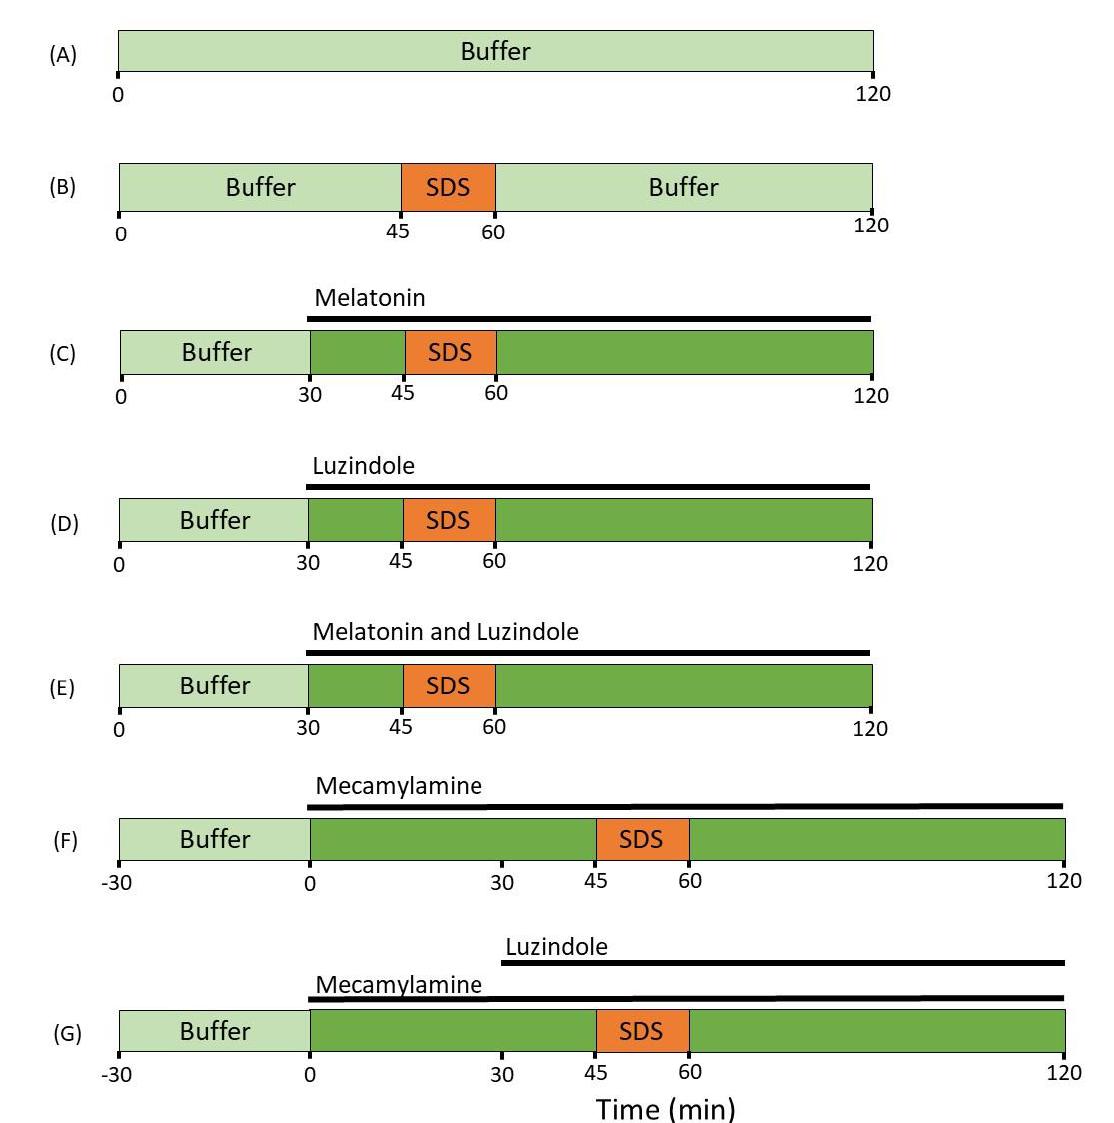
Figure 3. The luminal compositions, conditions, and treatments of the seven different experimental groups. The jejunal segment of rats ( n = 6 in each group) was single-pass perfused with a pH 6.5 saline buffer solution without ( A ) or with ( B – G ) adding 5 mg/mL SDS between 45 and 60 min. Melatonin ( C ), luzindole ( D ) or a combination of the two ( E ), were added from 30 min onward to evaluate their effects on the SDS-induced increases in intestinal mucosal permeability. In the two mecamylamine groups ( F , G ), an additional 30 min of control period was added before the beginning of the experiment to evaluate its effects on basal permeability. Mecamylamine alone ( F ) or in a combination with luzindole (from 30 min onwards, ( G )), was added from 0 min onward to evaluate their effects on the SDS-induced increases in intestinal mucosal permeability.